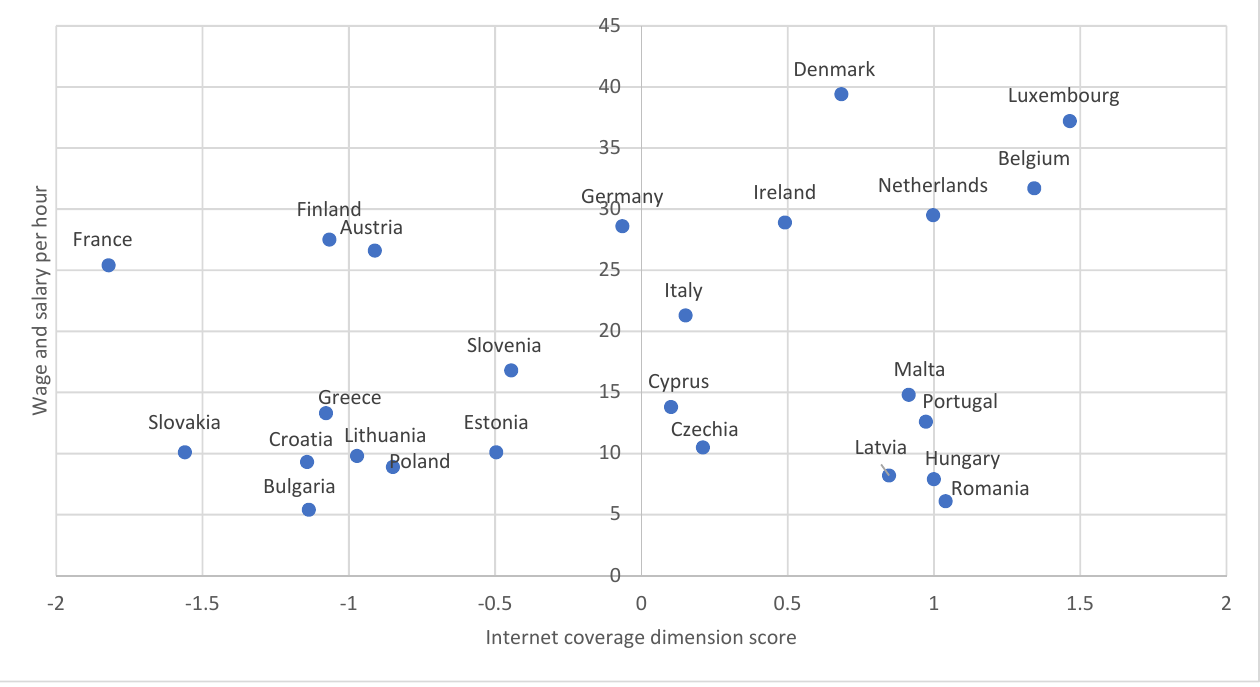
Figure 2. Internet coverage dimension and wages. Source: authors’ own calculations. However, the results reveal a less significant correlation (Pearson coefficient = 0.252, p = 0.205) among EU member states between the Internet coverage dimension score and, respectively, salaries and wages. Still, the relationship between these variables allows for the identification of four clusters: member states with high salaries and high Internet cov ‐ erage component score (such as Denmark, Luxembourg, Ireland, the Netherlands, or Bel ‐ gium), member states with low salaries and low Internet coverage component score (such as Slovakia, Bulgaria, Croatia, Greece, Lithuania, or Poland); member states with high sal ‐ aries and lower Internet coverage component score (such as France, Finland, or Austria); member states with low salaries and high Internet coverage component score (such Hun ‐ gary, Portugal, Romania, Malta, or Latvia).